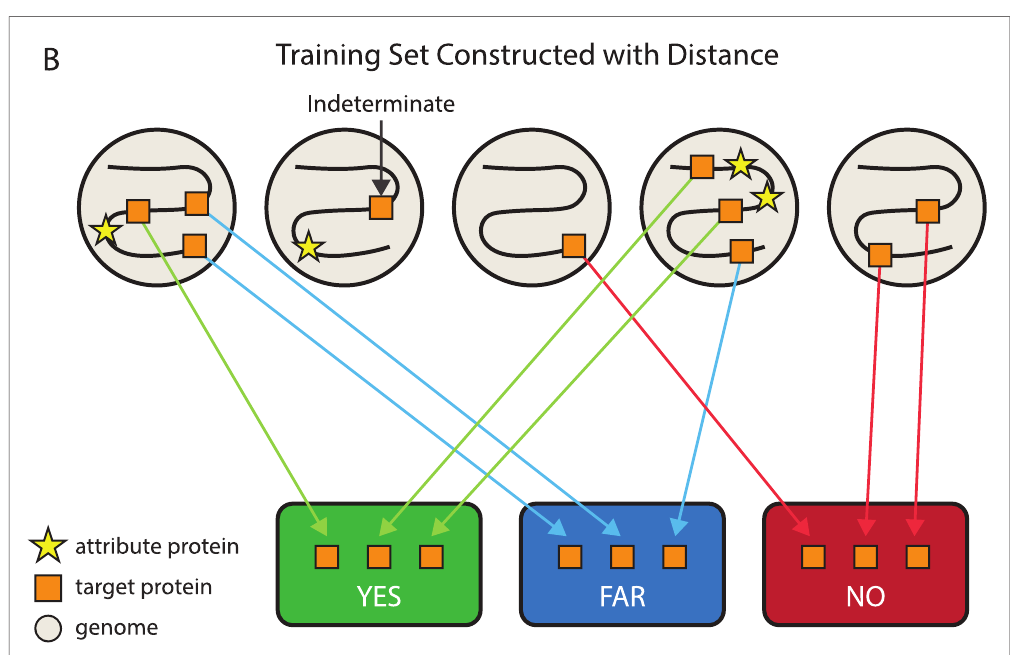
PLOS ONE | DOI:10.1371/journal.pone.0171758 February 9, 2017 5 /